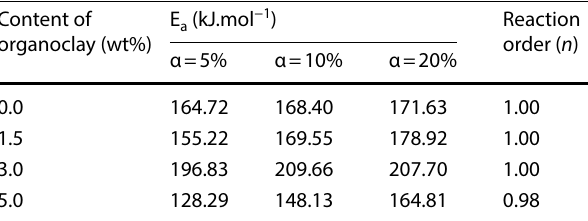
The confidence limit was fixed in the range of ±